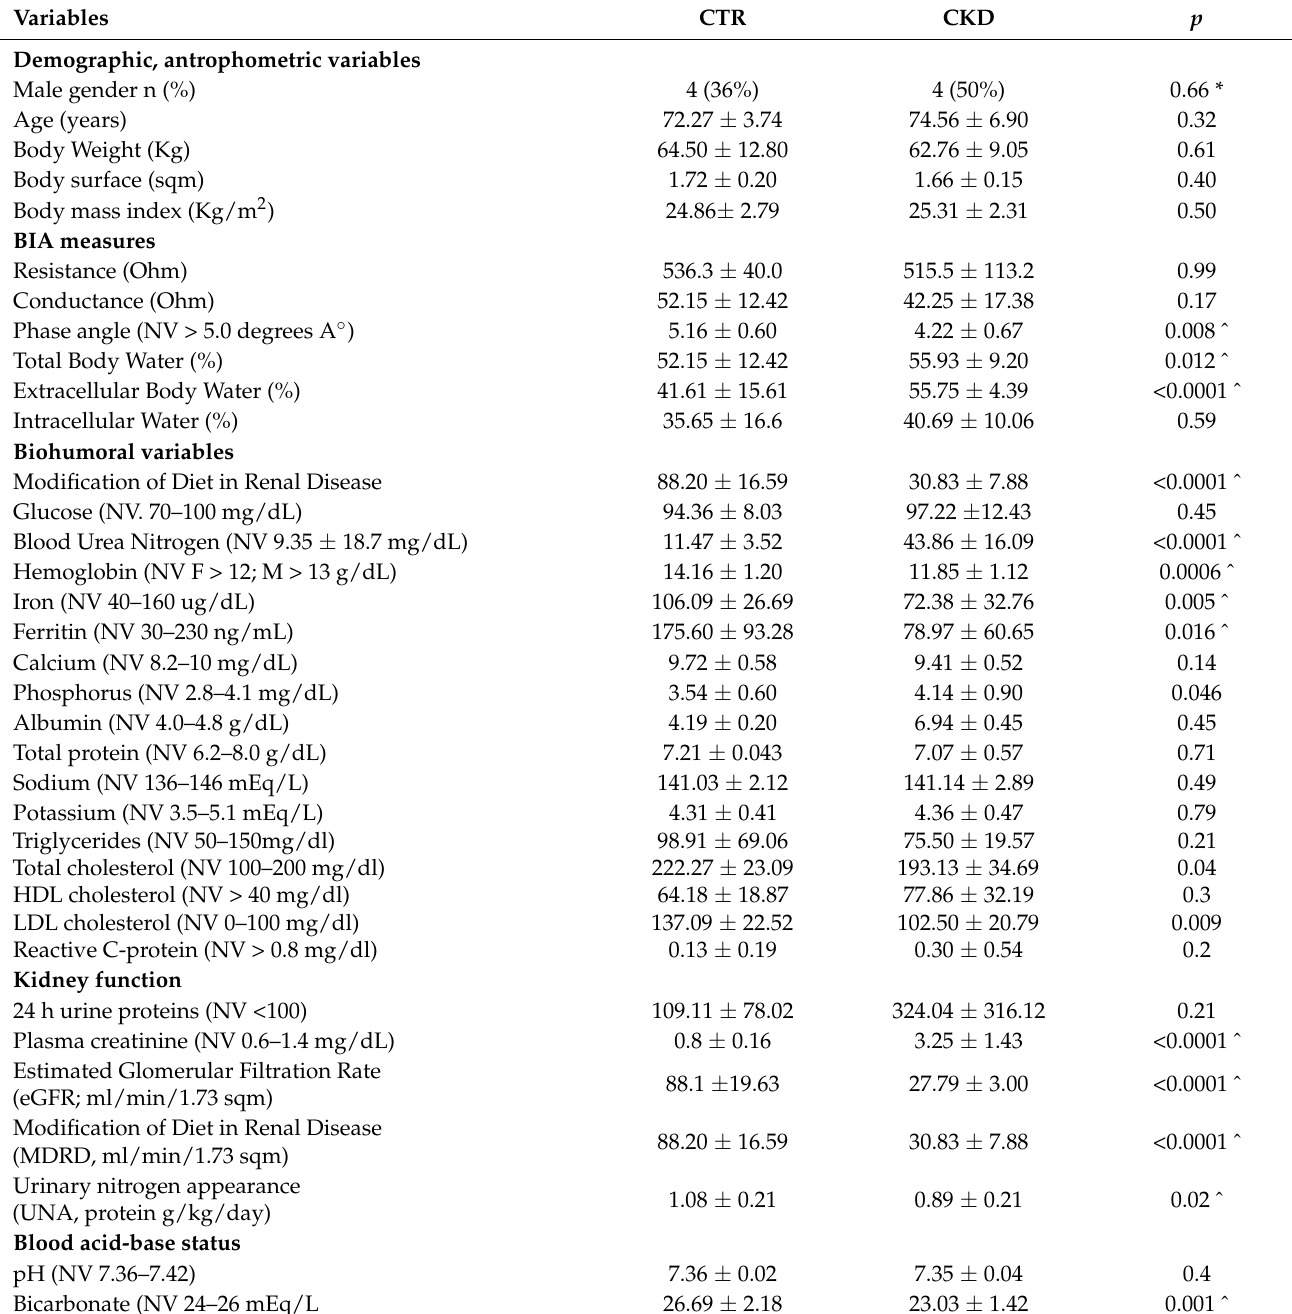
Table 2. Baseline characteristics of controls (CTR) and Chronic Kidney Disease (CKD) patients.